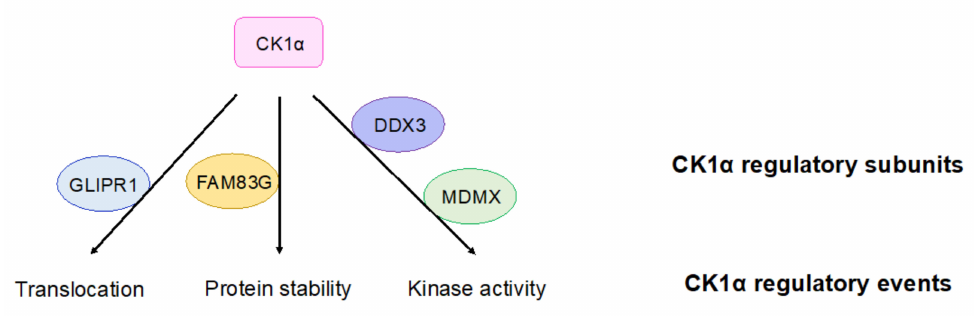
Figure 3. CK1 α regulatory subunits. Proteins that have been reported to regulate CK1 α are shown. These proteins bind to CK1 α and lead to indicated regulatory outcomes of CK1 α . GLIPR1: